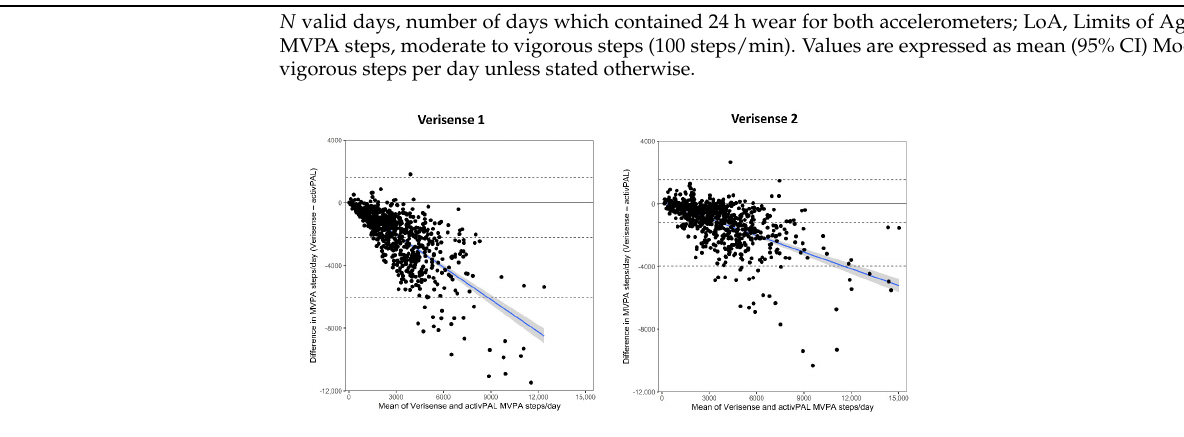
Figure 3. Bland–Altman plot showing the differences in MVPA steps/day derived from the Verisense 1 and Verisense 2 algorithms compared with the activPAL across the mean total steps/day for the overall sample. The blue line depicts mean (95% CI) proportional bias. Dashed black lines depict ± 95% limits of agreement and mean bias. LoA, Limits of Agreement.